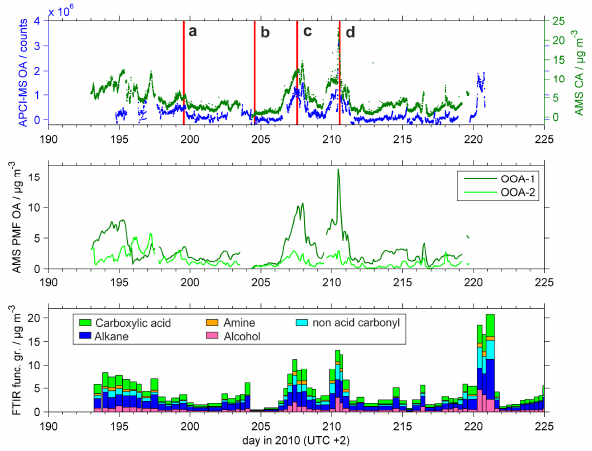
Fig. 1. Temporal variation of organic aerosol during HUMPPA- Figure 1. Temporal variation of organic aerosol during HUMPPA-COPEC 2010. Top panel: 3 COPEC 2010. Top panel: summation of particle-phase signals be- Summation of particle phase signals between m/z 150 and 500 measured by APCI-IT-MS 4 tween m/z 150 and 500 measured by APCI-IT-MS (blue) vs. the (blue) vs. the total submicron organic mass concentration measured by AMS (green). Middle 5 total submicron organic mass concentration measured by AMS panel: Two factor PMF analysis of AMS data (OOA: Oxygenated Organic Aerosol, factor -1 6 (green). Middle panel: two-factor PMF analysis of AMS data and OOA-2, see text). Lower panel: Mass concentration of functional groups measured by 7 (OOA: oxygenated organic aerosol, factor OOA-1 and OOA-2; see filter-FTIR. 8 text). Lower panel: mass concentration of functional groups mea- sured by filter-FTIR.